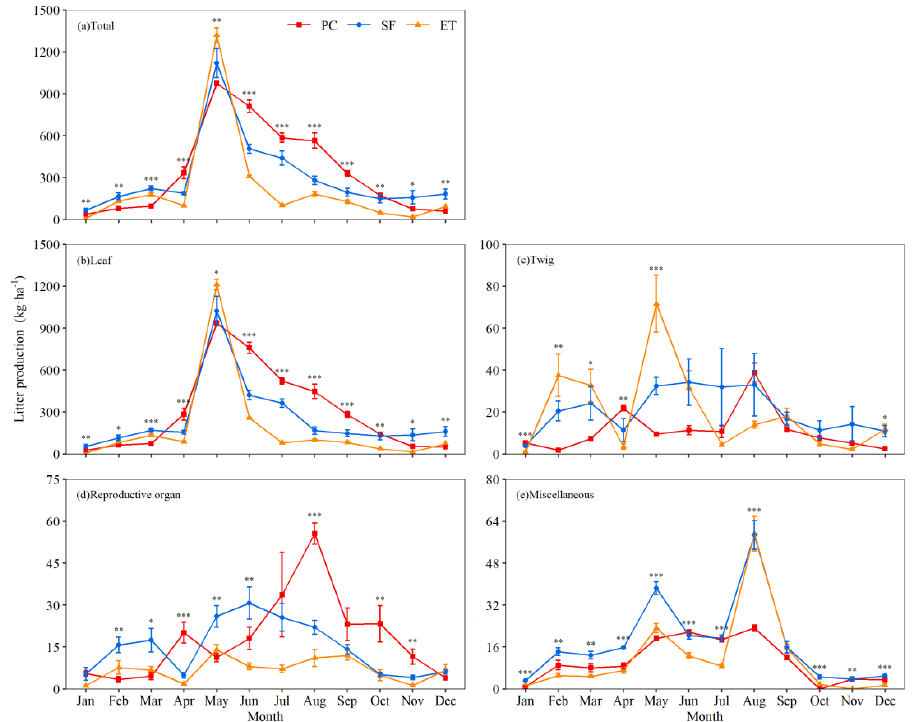
Figure 3. Monthly production of total litterfall ( a ) and its components (( b ) leaf litter; ( c ) twig litter; ( d ) reproductive organ litter; ( e ) miscellaneous litter) in different plantations. PC: pure cypress; SF: strip filling; ET: ecological thinning. Asterisks denote significant differences among the three plantations within the same month: * indicates p < 0.05; ** indicates p < 0.01; and *** indicates p < 0.001.